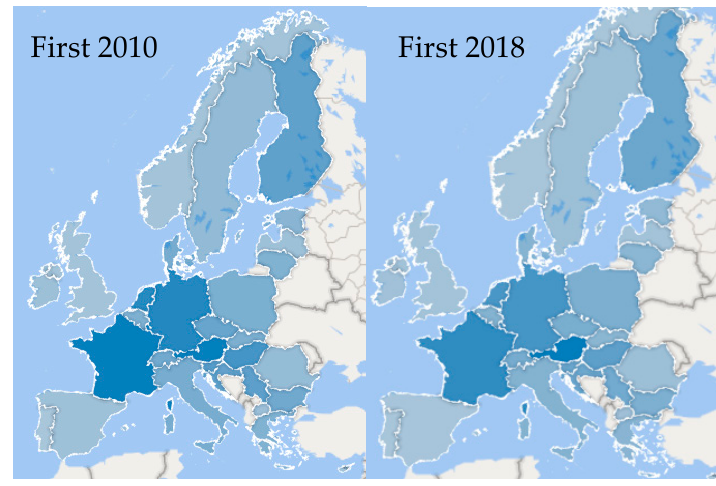
Figure 8. Number of long precedence by country, 2010–2018—geospatial distribution.